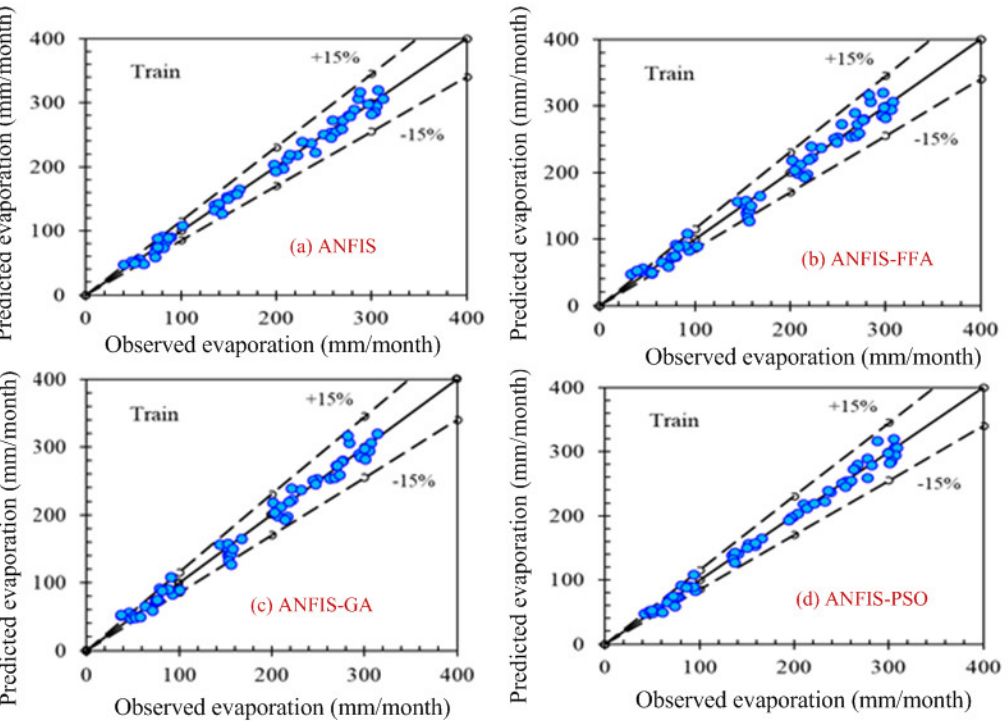
Figure 5. Comparison of the target (predicted) and obtained output sample index of training data set for ( a ) ANFIS, ( b ) ANFIS–FFA, ( c ) ANFIS–GA, and ( d ) ANFIS–PSO, respectively, using the second combination of the data set.